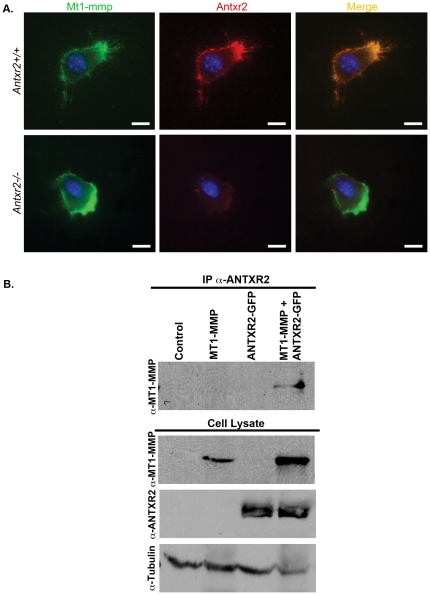
ANTXR2 and MT1-MMP colocalize and are found in complex.(A) Coimmunofluorescence for Mt1-mmp (green color) and Antxr2 (red color) on Antxr2+/+ and Antxr2−/− MEFs demonstrate that MT1-MMP and ANTXR2 colocalize at the cell surface (orange). DAPI (blue color) is used for nuclear staining. Scale bars, 5 µm. (B) 293T cells were transfected with empty vector, MT1-MMP, ANTXR2-GFP or MT1-MMP and ANTXR2-GFP. Cell lysates were immunoprecipitated with antibody against ANTXR2 followed by western blotting to detect MT1-MMP. The coimmunoprecipitation revealed that ANTXR2 and MT1-MMP are found together in complex. A representative of two independent experiments is shown.